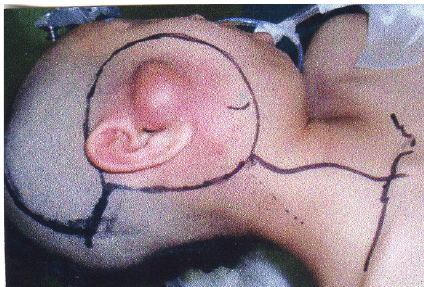
Figure 2: Skin incision. Resection of skin, including